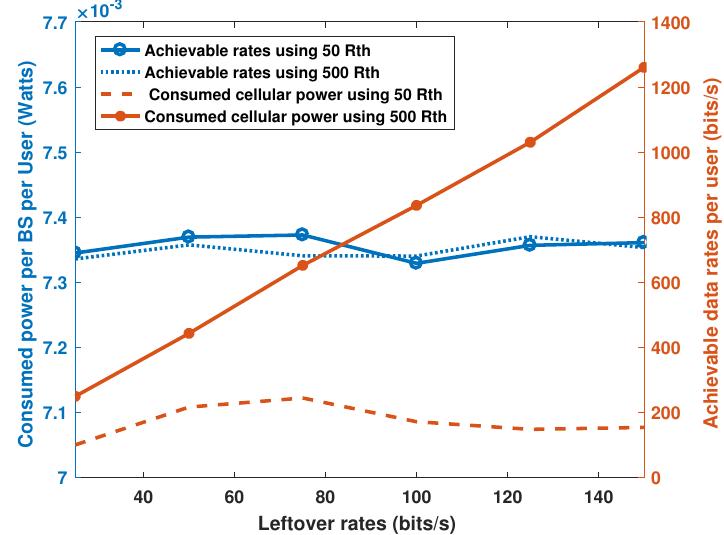
Figure 4. Analysis of rate allocation in Wi-Fi Offloading regarding leftover rate.